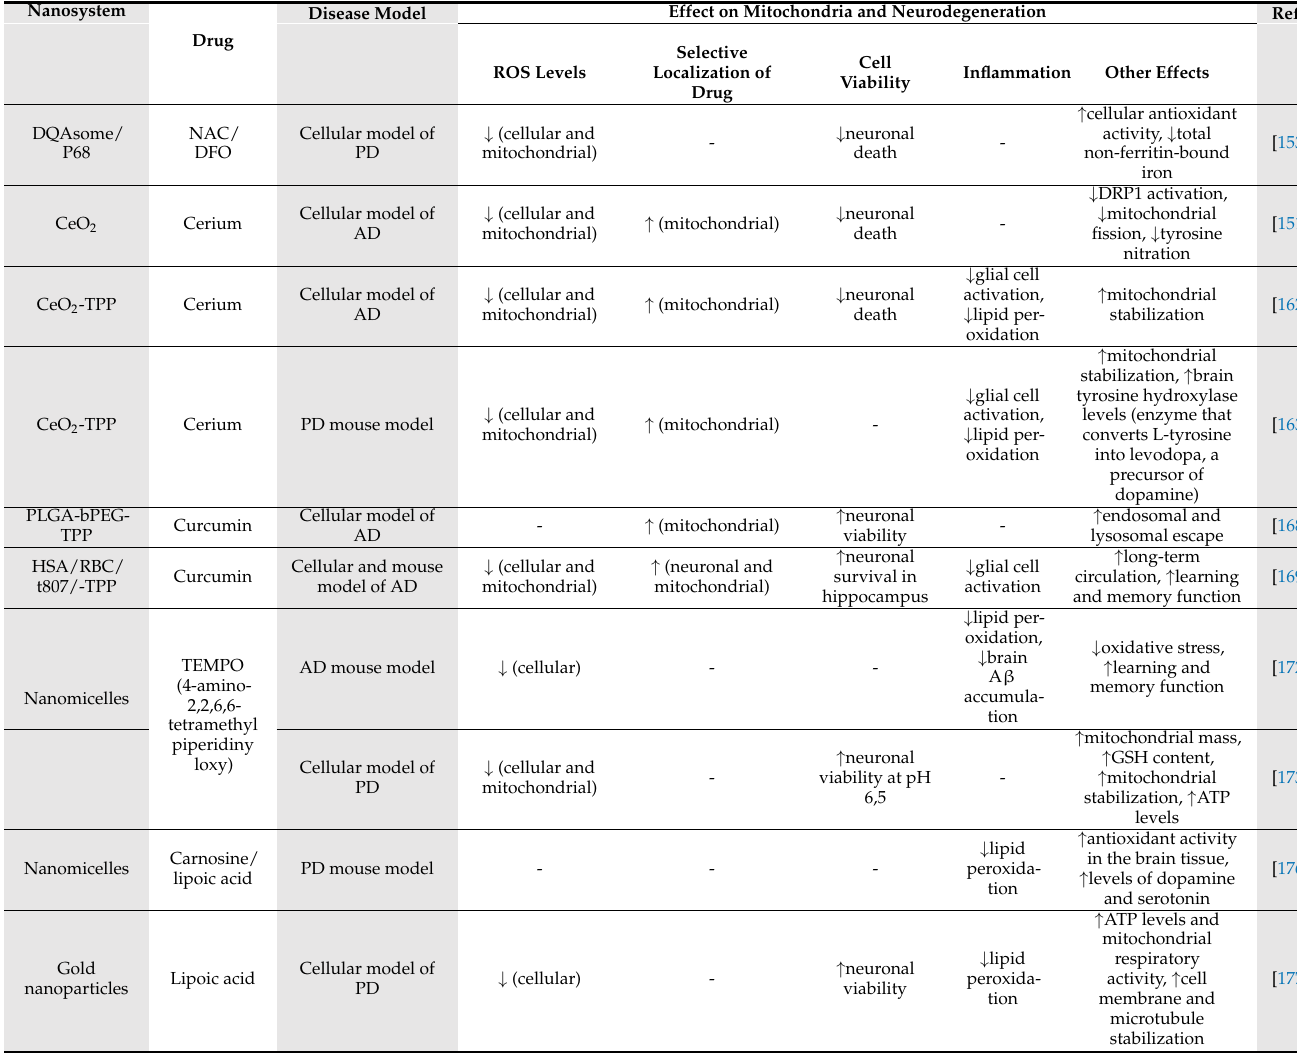
Nanosystems containing antioxidant agents to repair mitochondrial function in models of neurodegenerative